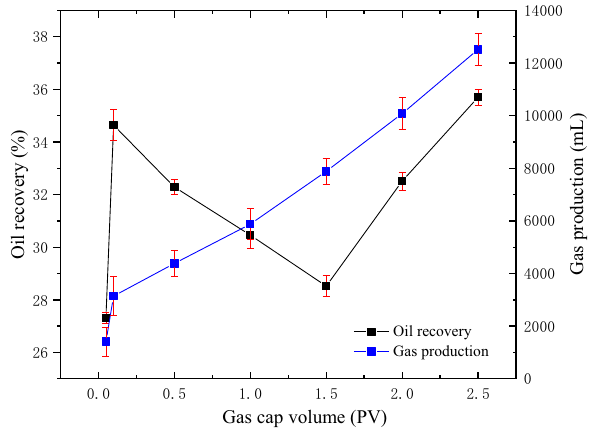
Fig. 3 The influence of gas cap volume on the oil recovery and gas